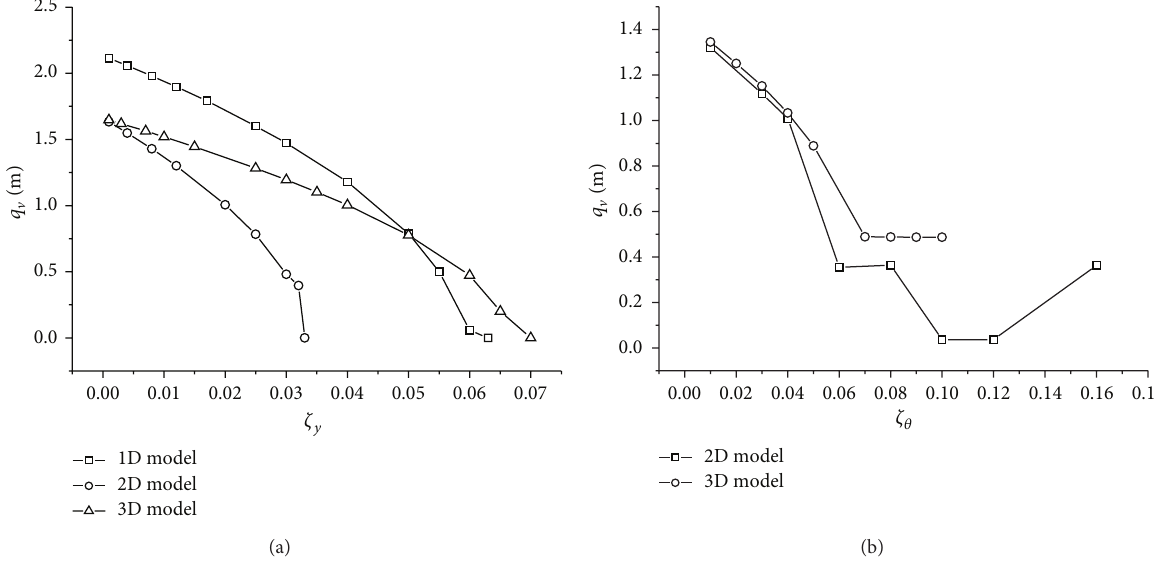
Figure 8: The influence of the damping ratio on the galloping amplitude: (a) vertical amplitude and (b) torsional amplitude.